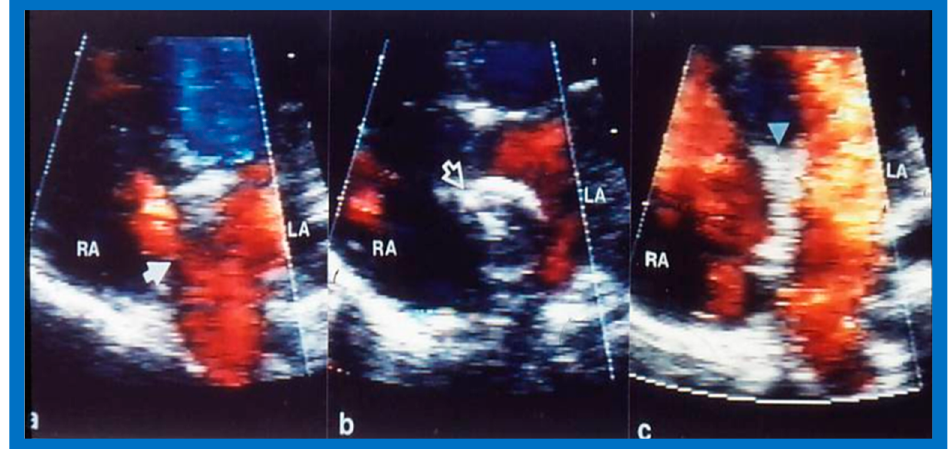
Figure 21. Selected video frames from transthoracic 2D and color Doppler echo demonstrating: ( a ) a shunt across the atrial septal defect (ASD) (filled arrow), ( b ) balloon sizing (unfilled arrow) of the ASD, and ( c ) the device in place (filled arrowhead) without residual shunting. LA, left atrium; RA, right atrium. Reproduced from Reference [45].